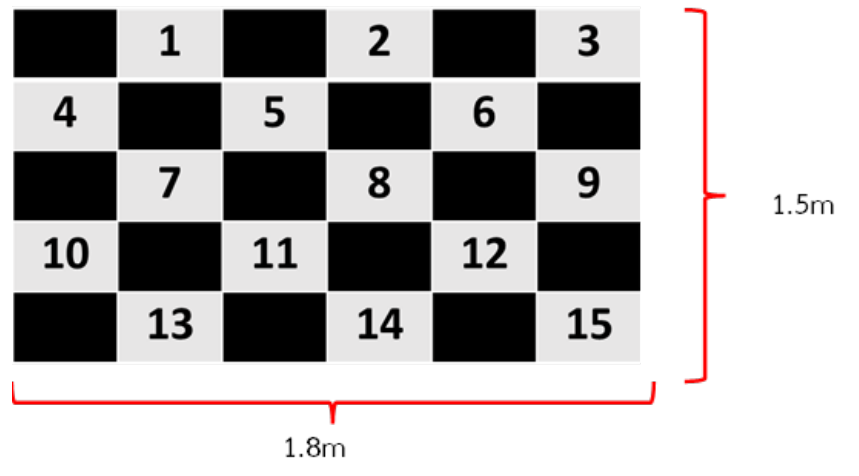
Figure 7. Trial installation area for preliminary test kit.